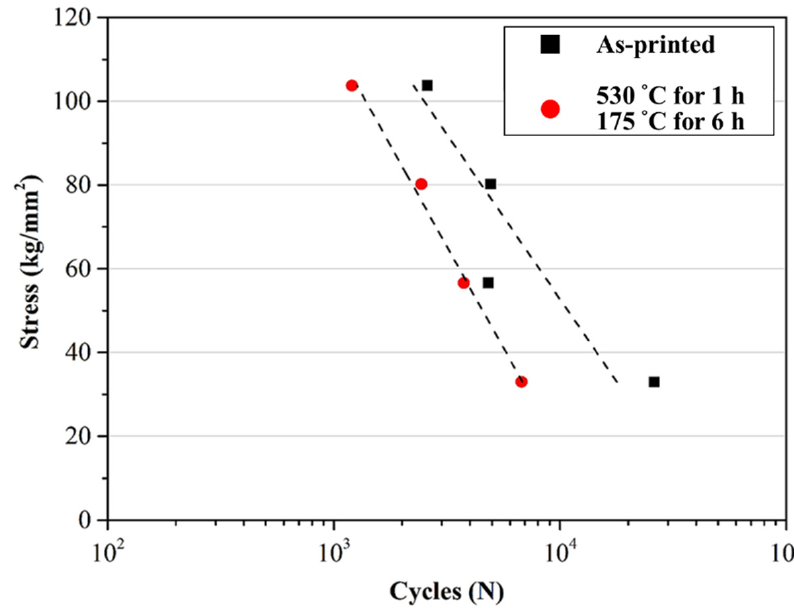
Figure 9. S – N data of the Al-Ni-Cu alloy before and after solution treatment.